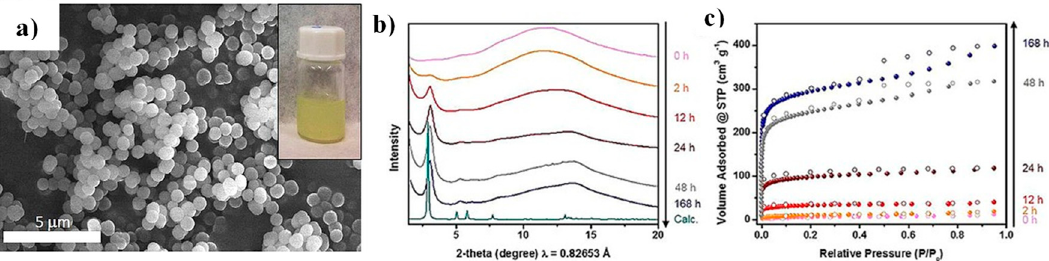
Figure 2. ( a ) Field emission scanning electron microscopy (FESEM) image of c-1 spheres, and evolution of the crystallinity ( b ) and porosity ( c ) of the composite during the amorphous-to-crystalline transformation. Reprinted with permission from [35]. Copyright (2017) Wiley-VCH Verlag GmbH and Co. KGaA,